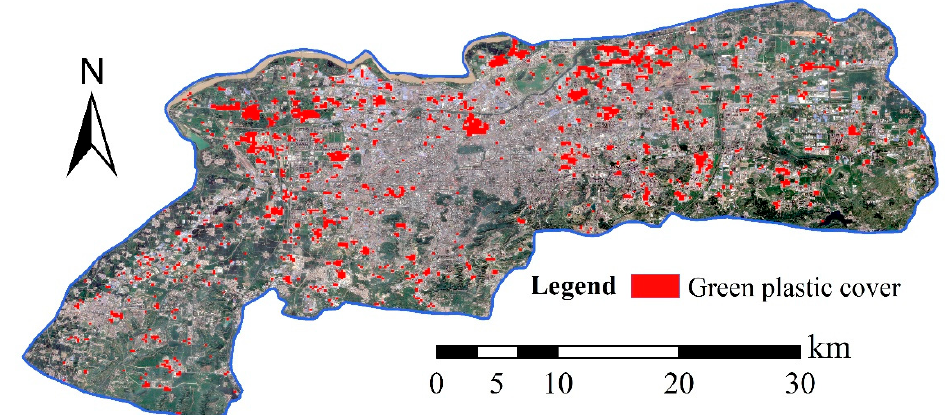
Figure 9. Mapping results of green plastic cover using Sentinel-2 data.